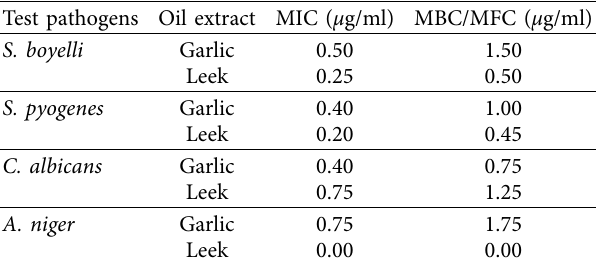
Table 4: MIC, MBC, and MFC of garlic bulb and leek leaf oil extracts.